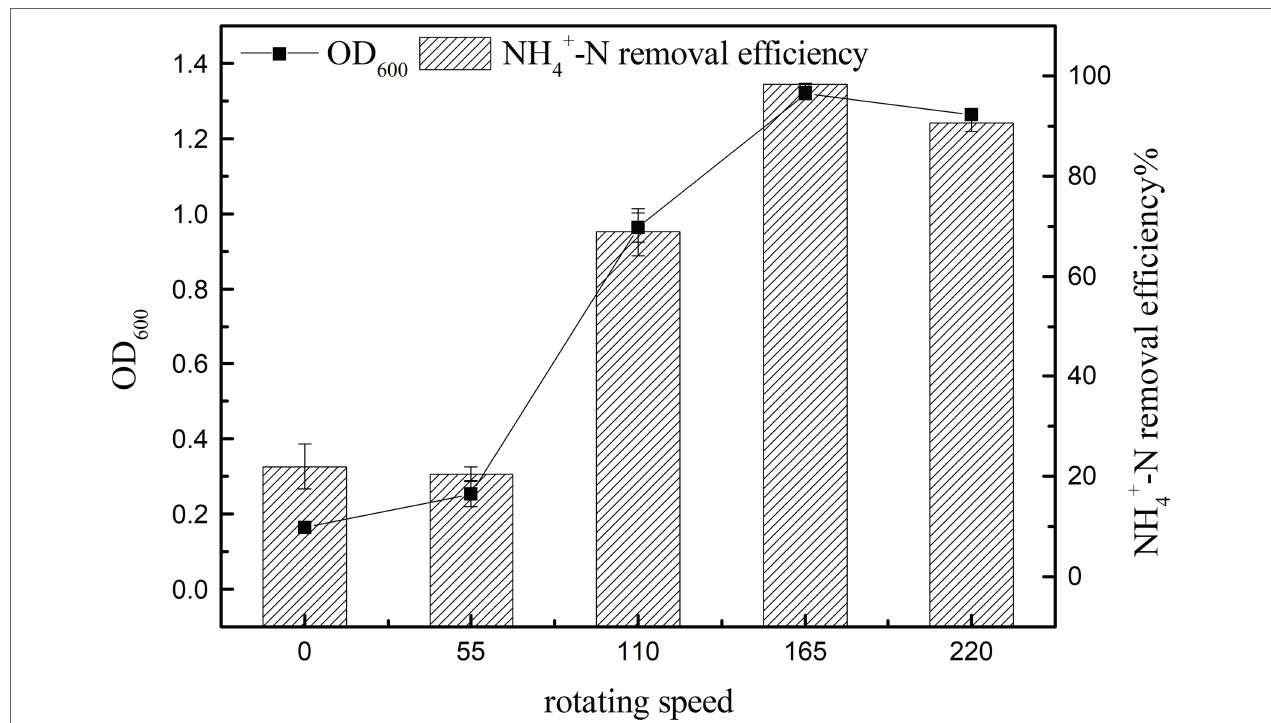
FIGURE 6 | Effect of rotation speed on the growth and ammonia nitrogen removal efficiency of strain K17. The mixture was cultured at 165 rpm and 30 ° C for 12